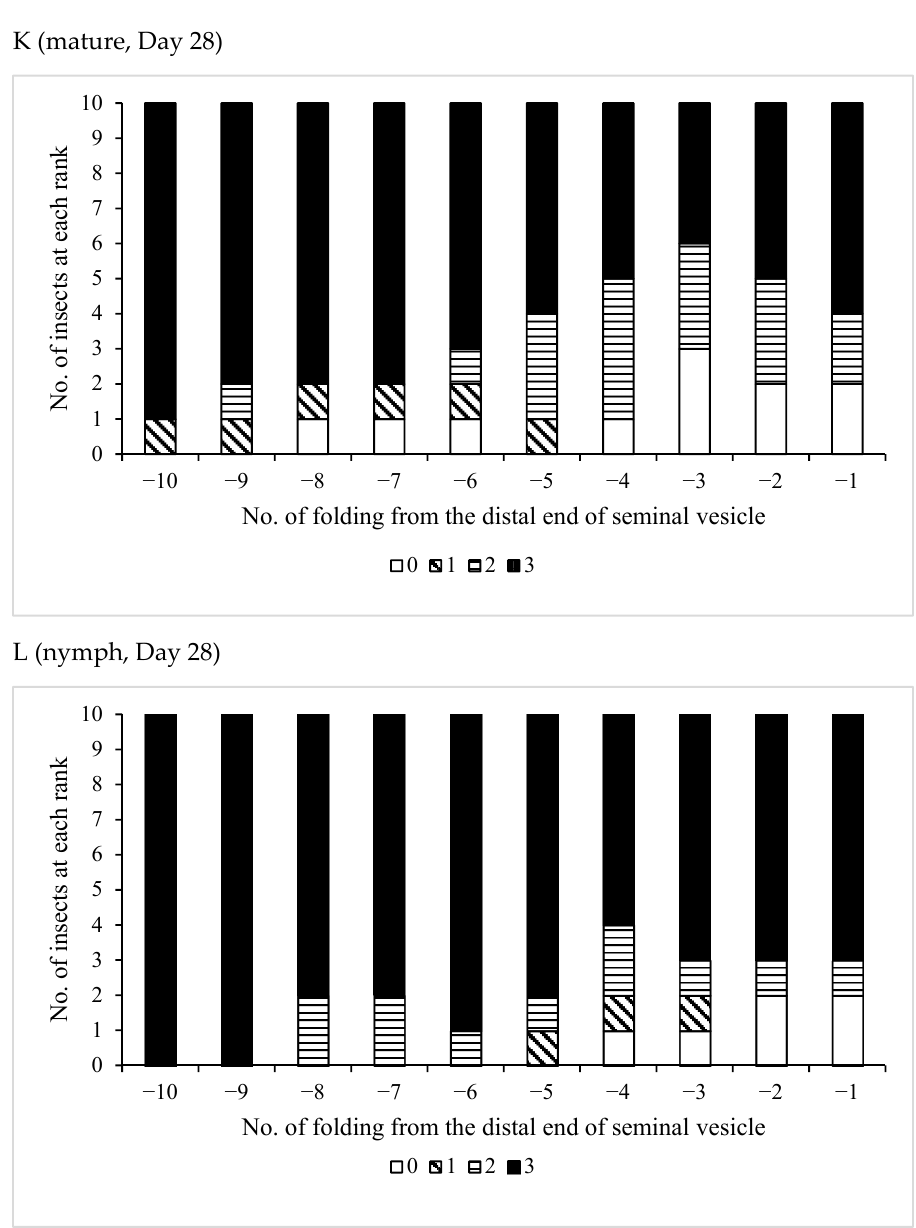
Figure 3. Distribution of sperm in the proximal part ( A , E , I ) or the distal part ( C , G , K ) of the seminal vesicle of the gregarious form, when immature adult locusts were influenced by the maturation accelerating pheromones, and that in the proximal part ( B , F , J ) or the distal part ( D , H , L ) of the seminal vesicle of the gregarious form of the desert locust, Shistocerca gregaria , when immature adult locusts were influenced by the maturation retarding pheromones. ( A – D ), ( E – H ), and ( I – L ) indicate Day 7, 14, and 28 of adult life, respectively. The number of sperm was classified into four categories by observing each fold region of the seminal vesicle under a microscope as follows; 0 = empty, 1 = several free sperm and/or <10 sperm bundles are seen in the fold (a few), 2 = ≥ 10 dispersed sperm bundles and/or intermittent sperm bundles mass (common), and 3 = many sperm bundles are packed tightly in the fold (many).